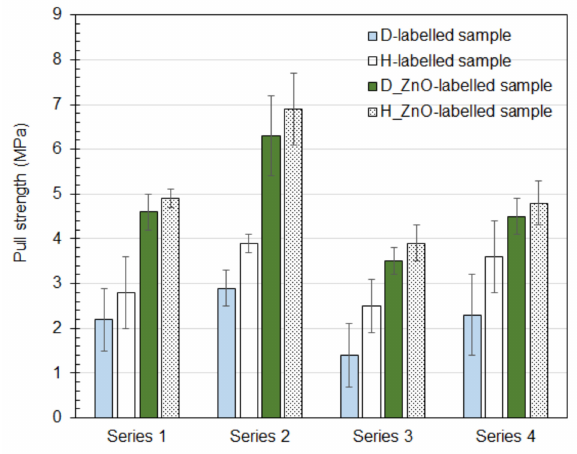
Figure 6. Adhesion (expressed as pull strength) of coatings based on latexes, differing in the covalent crosslinking strategy, surfactant type and addition of nanostructured